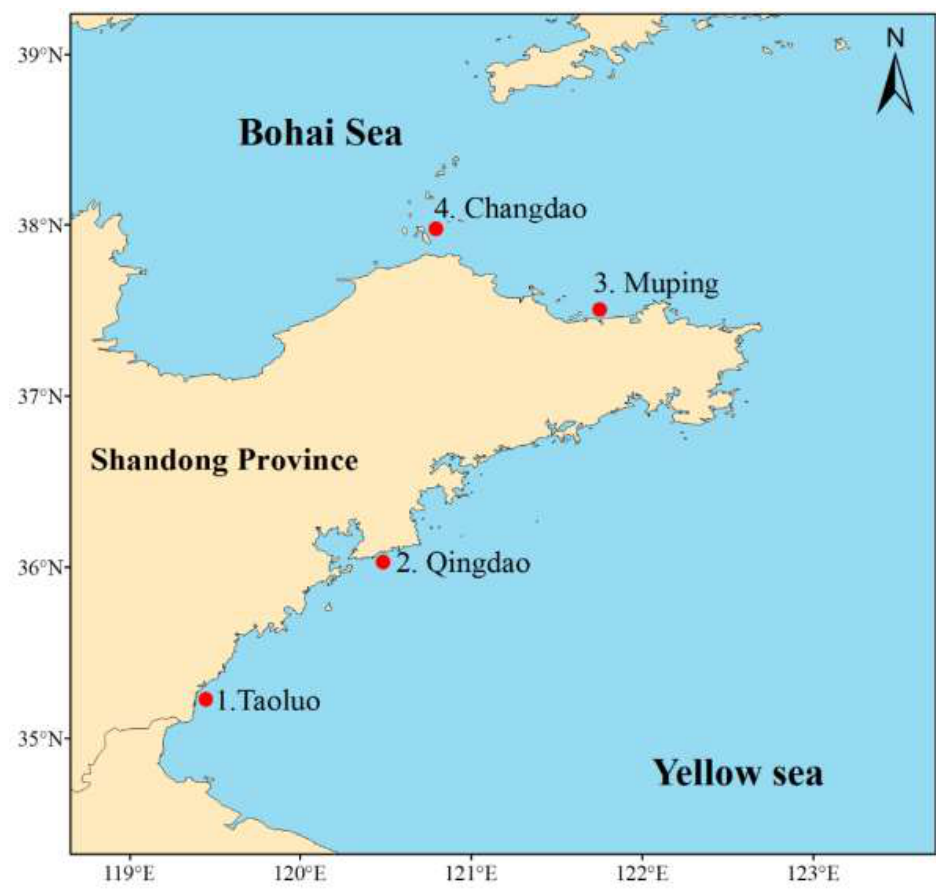
Figure 1. Diagram of sampling points.